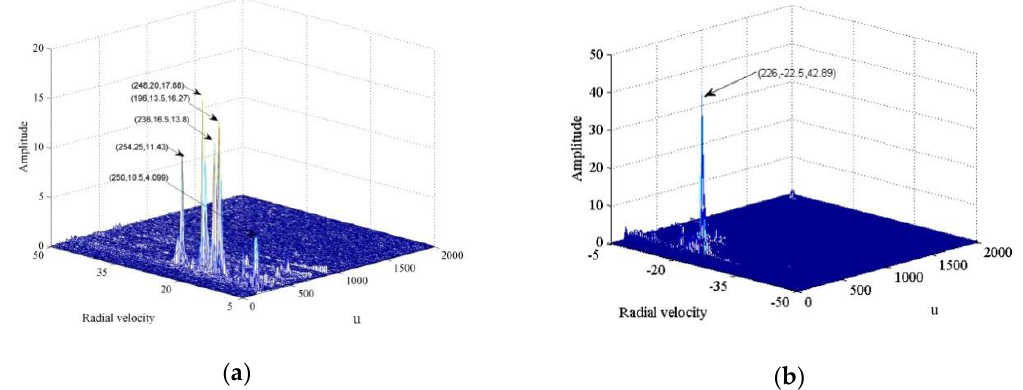
Figure 6. Proposed algorithm applied to ground vehicle detection and speed estimation. ( a ) Five targets with di ff erent velocities in the positive speed direction; ( b ) one target with velocity − 22.5 m/s in the negative speed direction.